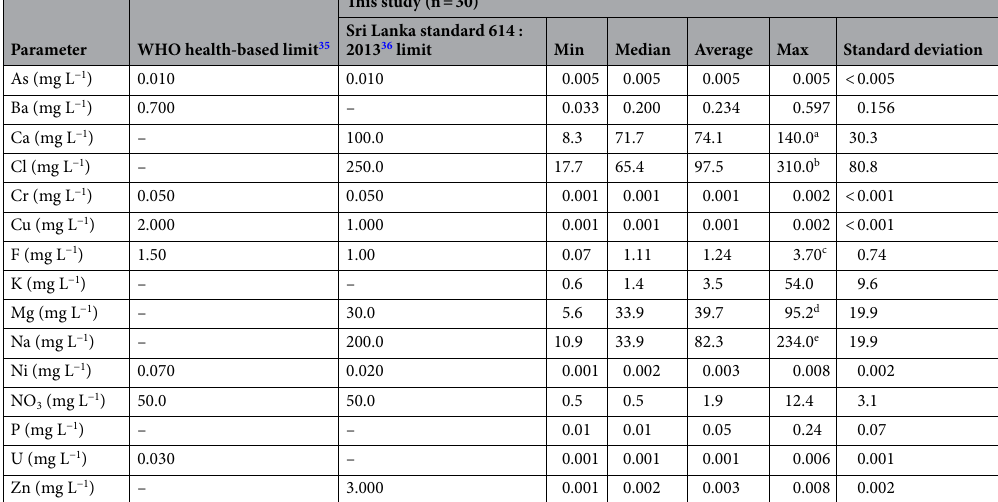
Table 1. World Health Organization (WHO) and Sri Lanka drinking water standard 614:2013 guideline values for inorganic water chemistry parameter limits in drinking water compared against values observed in this study. For the purposes of this assessment, samples falling below the limit of detection have been assigned a value equal to the limit of detection. a 4 of 30 samples exceed the SLSI guideline value. b 3 of 30 samples exceed the SLSI guideline value. c 17 of 30 samples exceed the SLSI guideline value, 9 of 30 samples exceed the WHO guideline value. c 21 of 30 samples exceed the SLSI guideline value. d 1 of 30 samples exceed the SLSI guideline